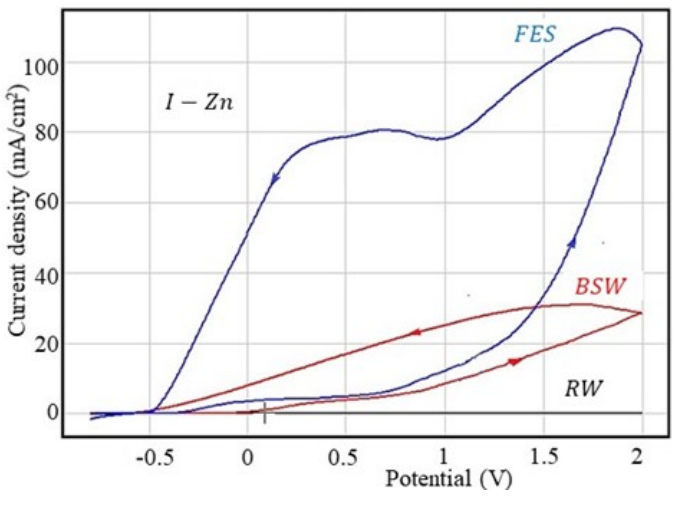
Table 7. Stimulated corrosion parameters for the I-Zn sample in the three corrosive environments.